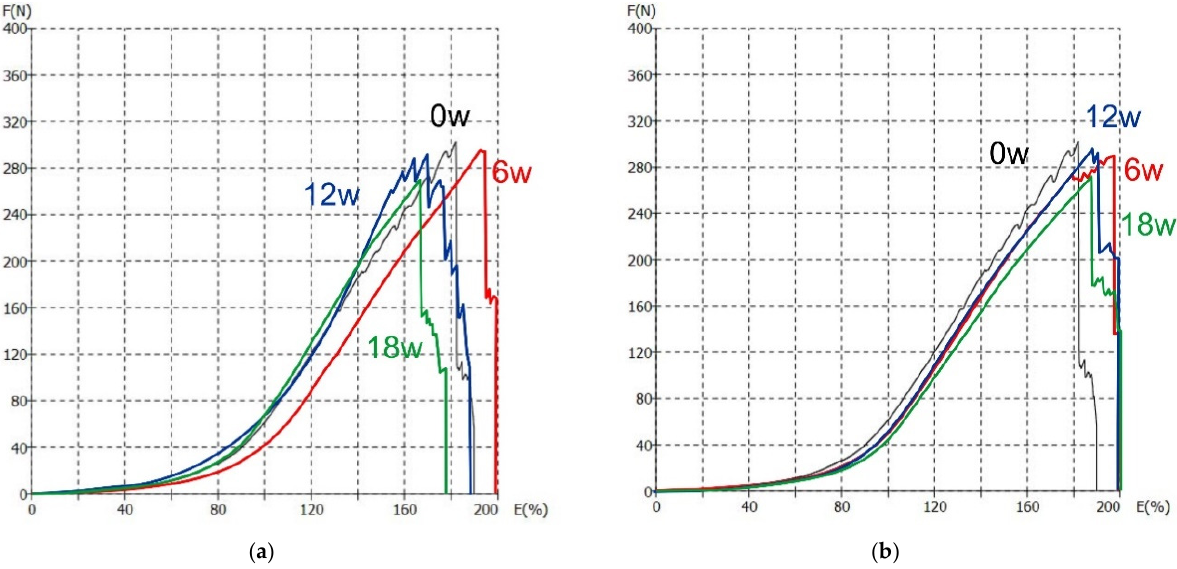
Figure 9. The F/E curves for material KF1: ( a ) In outdoor conditions; ( b ) in indoor conditions. The F/E curves of each material and each condition are further used to define the points associated with the regions and to define the fragments of elongation of the materials (expressed as percentages), Figures 10 and 11.